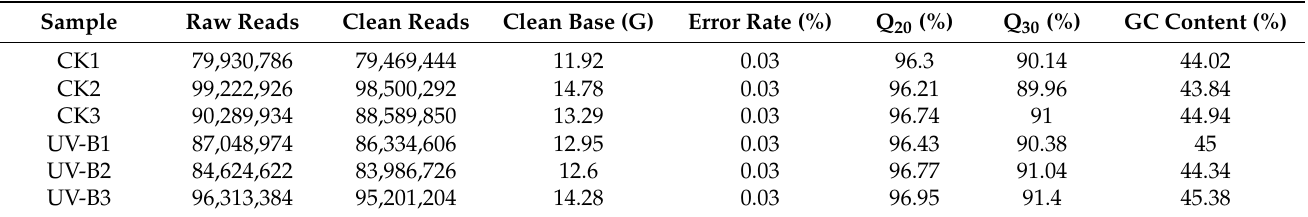
Table 1. Summary of RNA-seq data for the control (CK) and UV-B treatment groups of Pohlia nutans